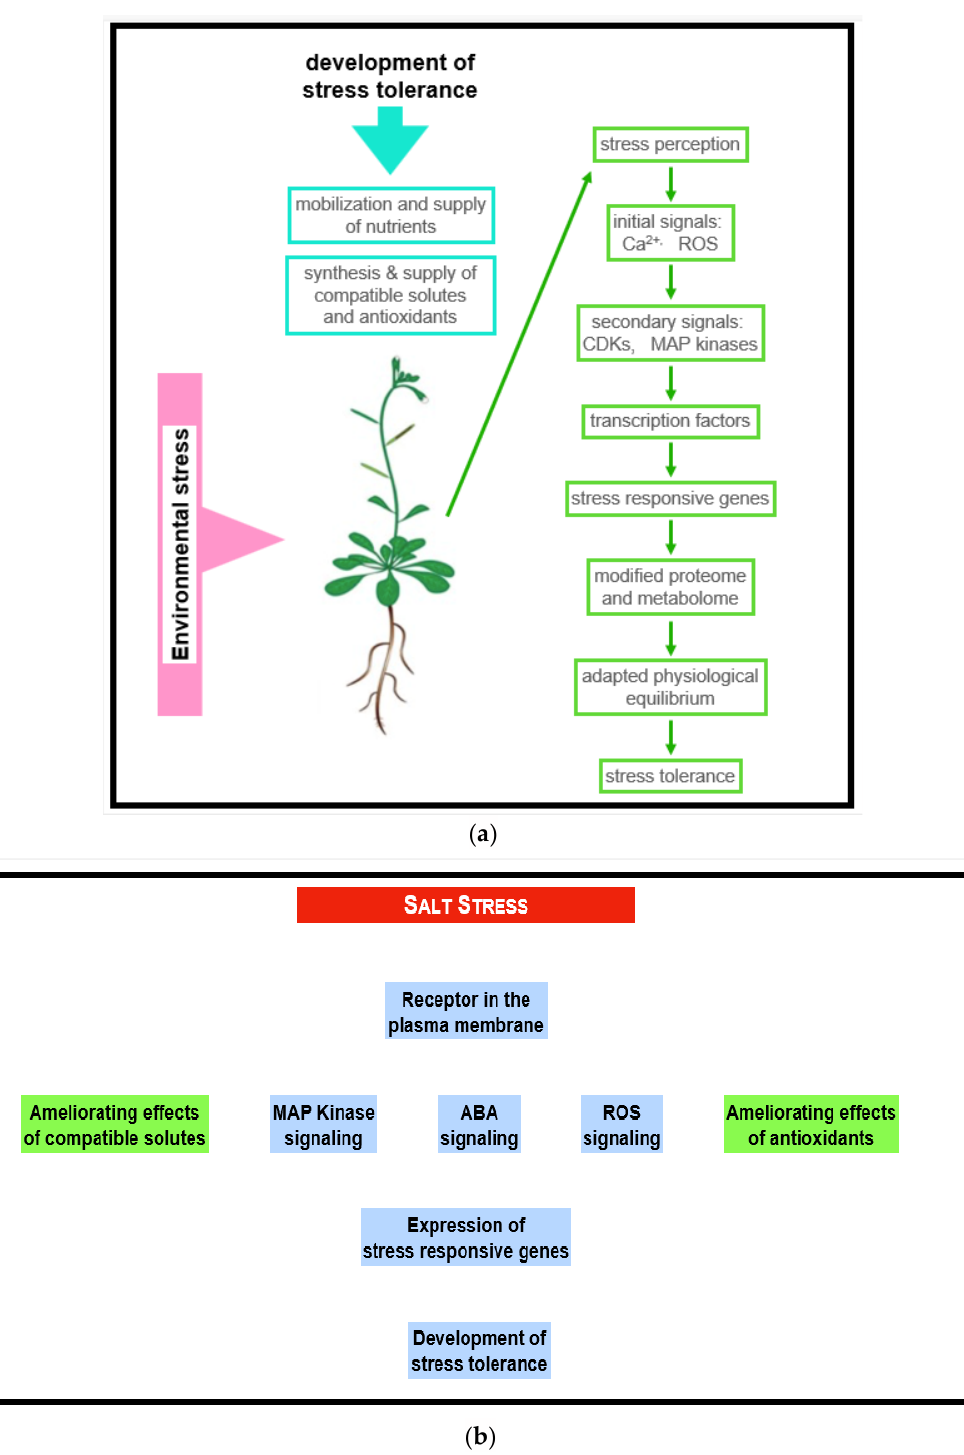
Figure 6. ( a ) A general concept of the reaction sequence leading to stress tolerance When analyzing plant responses to moderate drought and salt tolerance, a general scheme of responses was